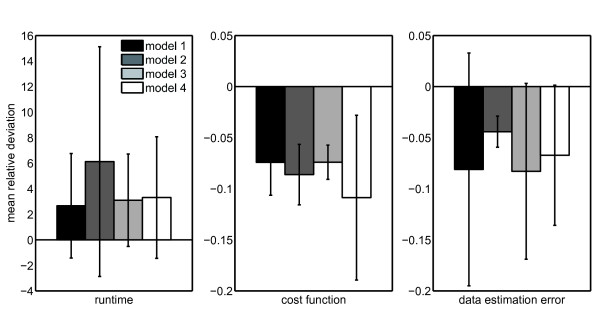
Performance on toy models. We validated our algorithm on graphs with predefined cluster structure. To this end, we compared it with the hard clustering method by Long et al. on four different random toy models, see Table 1. The plot shows the mean relative deviation between the two algorithms relative to the results of the hard clustering. Error bars denote standard deviations over 1000 runs. We see that the fuzzy cluster assignments of our method require much more runtime, but both cost function and data estimation error (see Methods) are significantly smaller. The large standard deviations show the dependency of the decomposition on the random initial conditions. Therefore, by default we perform multiple restarts with different initializations.